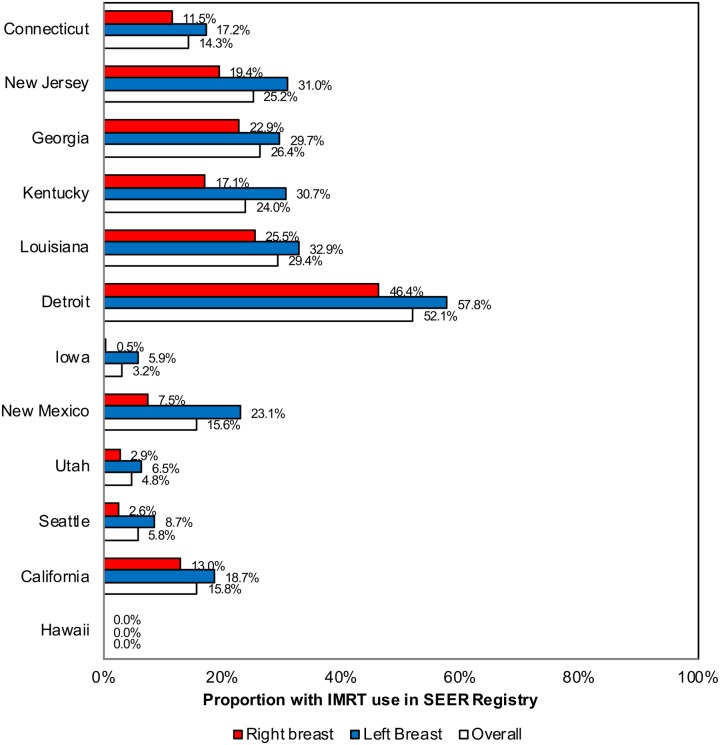
Proportion of early-stage breast cancer cases receiving intensity modulated radiation therapy following lumpectomy by Surveillance, Epidemiology, and End Results (SEER) registry in the SEER-medicare database.